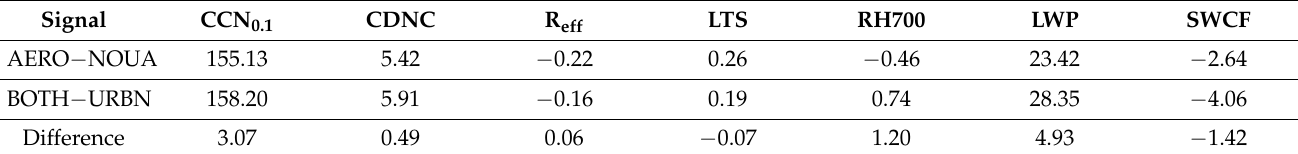
Table 2. NDJ-mean AA-induced changes in cloud condensation nuclei (CCN) number concentration at the supersaturation of 0.1% (CCN0.1; in #/cm 3 ) at 850 hPa, vertically integrated cloud droplet number concentration (CDNC; in 10 6 #/cm 2 ), cloud droplet effective radius (R eff ; in µ m) at 850 hPa, low tropospheric stability (LTS; in K), RH at 700 hPa (RH700; in %), cloud liquid water path (LWP; in g/m 2 ), and shortwave cloud forcing (SWCF, in W/m 2 ) averaged over southern China